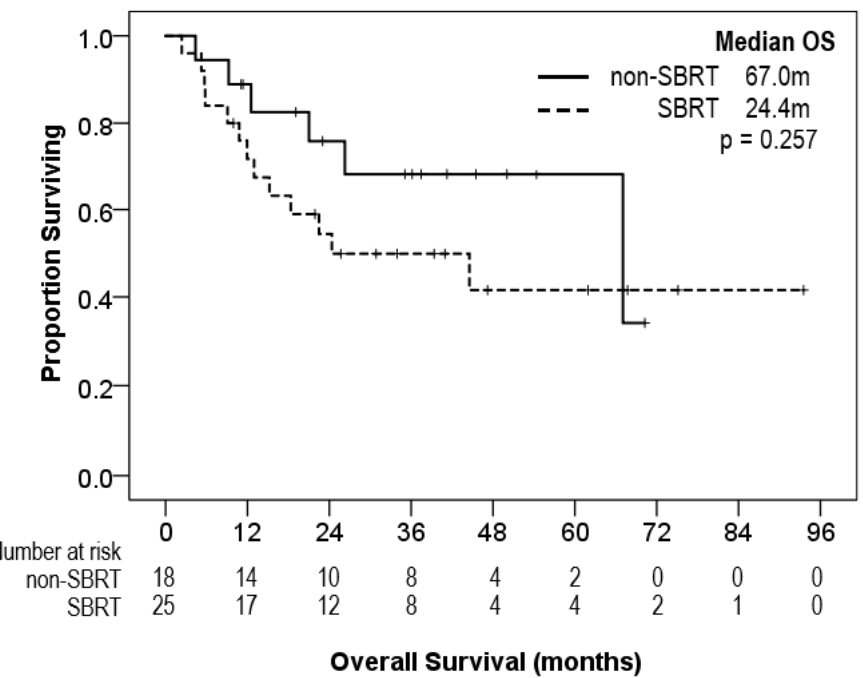
Figure 1. Overall survival (OS) comparing SBRT and curative-intent non-SBRT (surgery and conven- tional RT) cohorts.